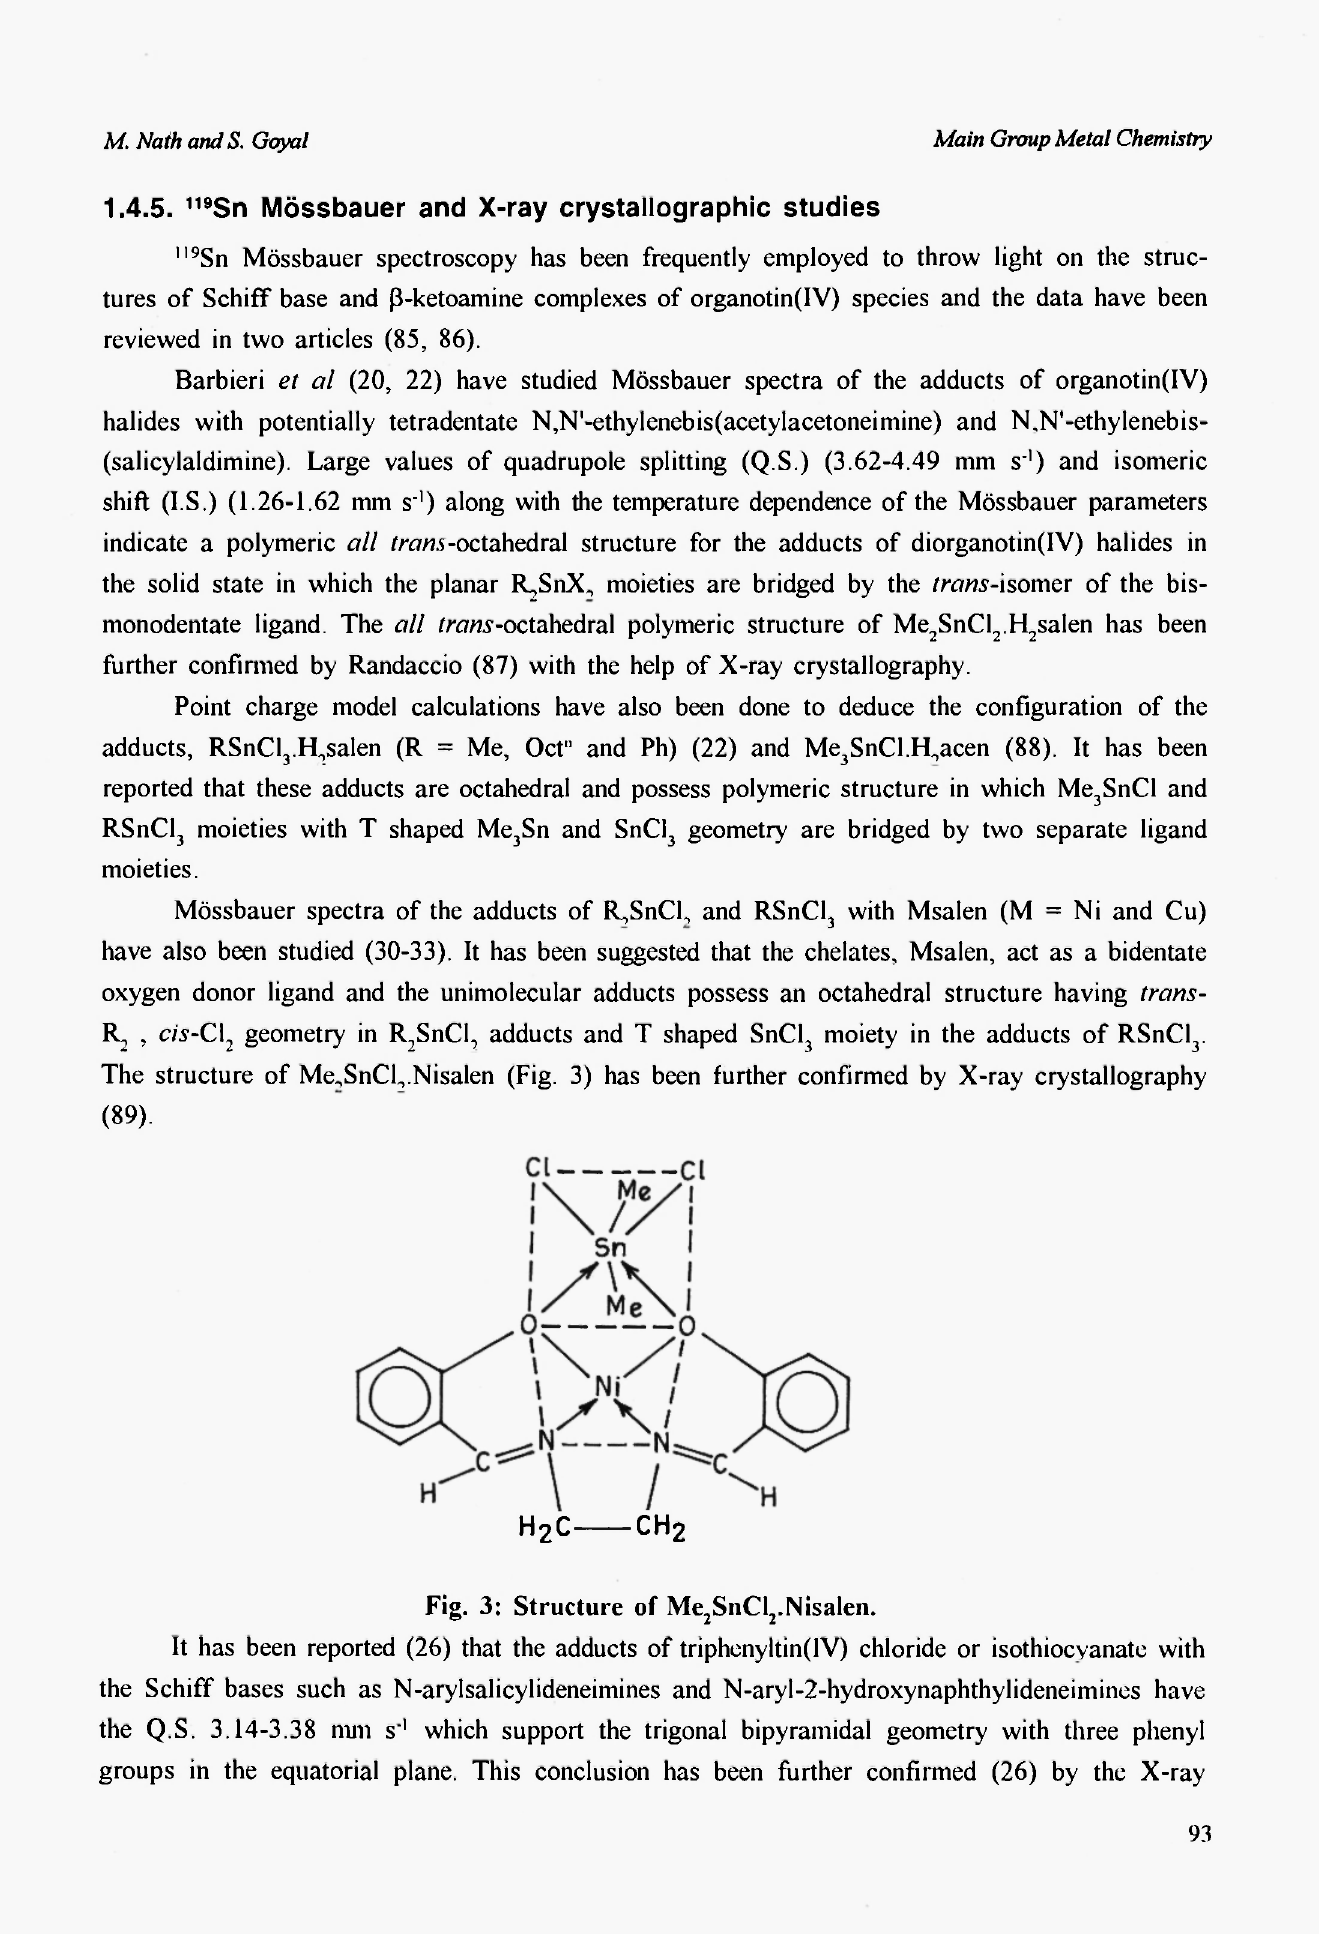
Fig. 3: Structure of Me